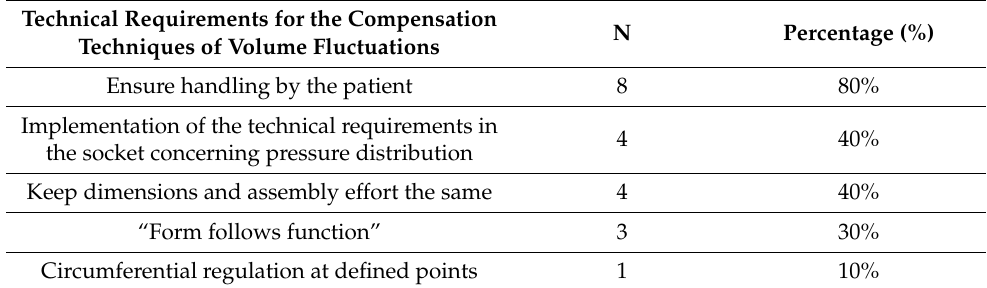
Table 2. The technical requirements surrounding the compensation techniques of volume fluctuations.